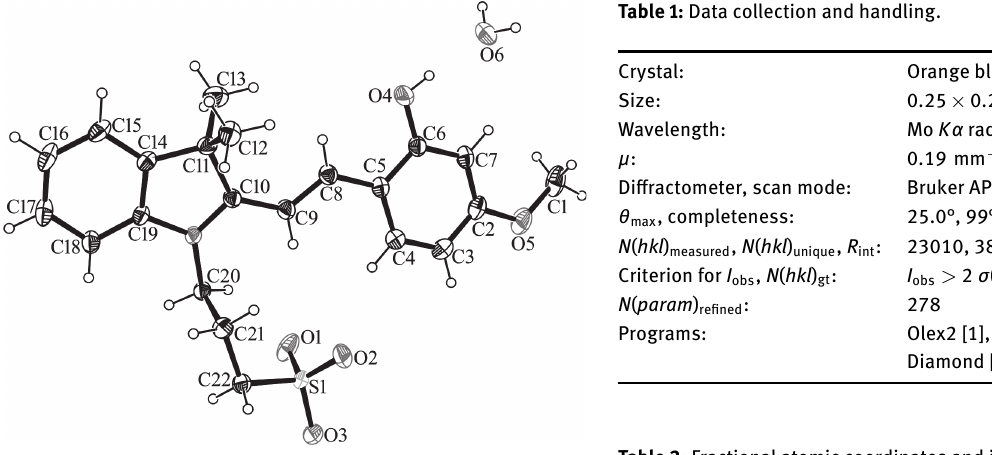
Table 1: Data collection and handling.